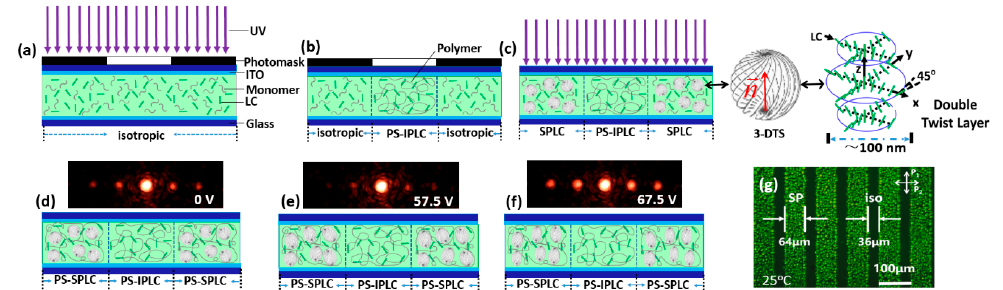
Figure 2. ( a – c ) Schematic diagram of the polymer-stabilized sphere phase liquid crystal (PS-SPLC) grating fabrication process. Diffraction pattern and possible schematic diagram of liquid crystalline molecular orientation of the PS-SPLC grating at ( d ) V = 0 V, ( e ) 57.5 V, and ( f ) 67.5 V. ( g ) the polarizing micrographs of PS-SPLC grating in reflection mode at the turn-off state.